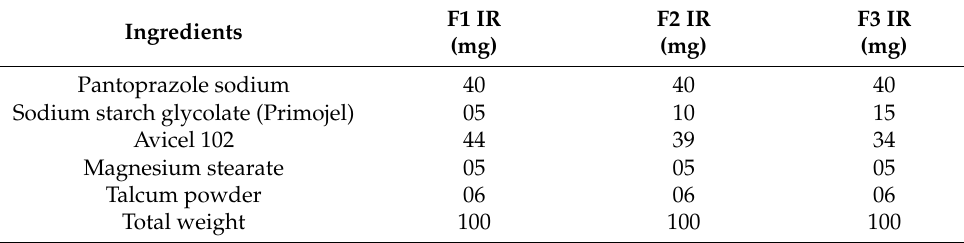
Table 6. Ingredients of the immediate-release layer of pantoprazole sodium.